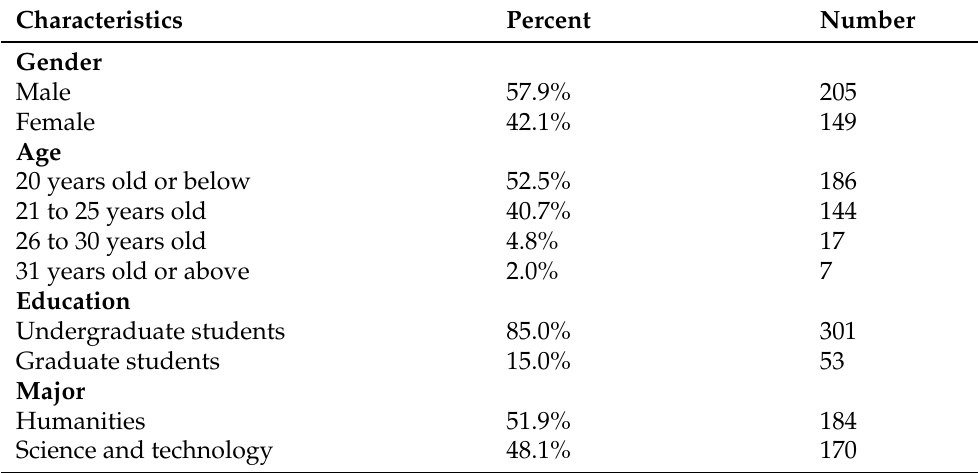
Table 1. Sample characteristics ( N =